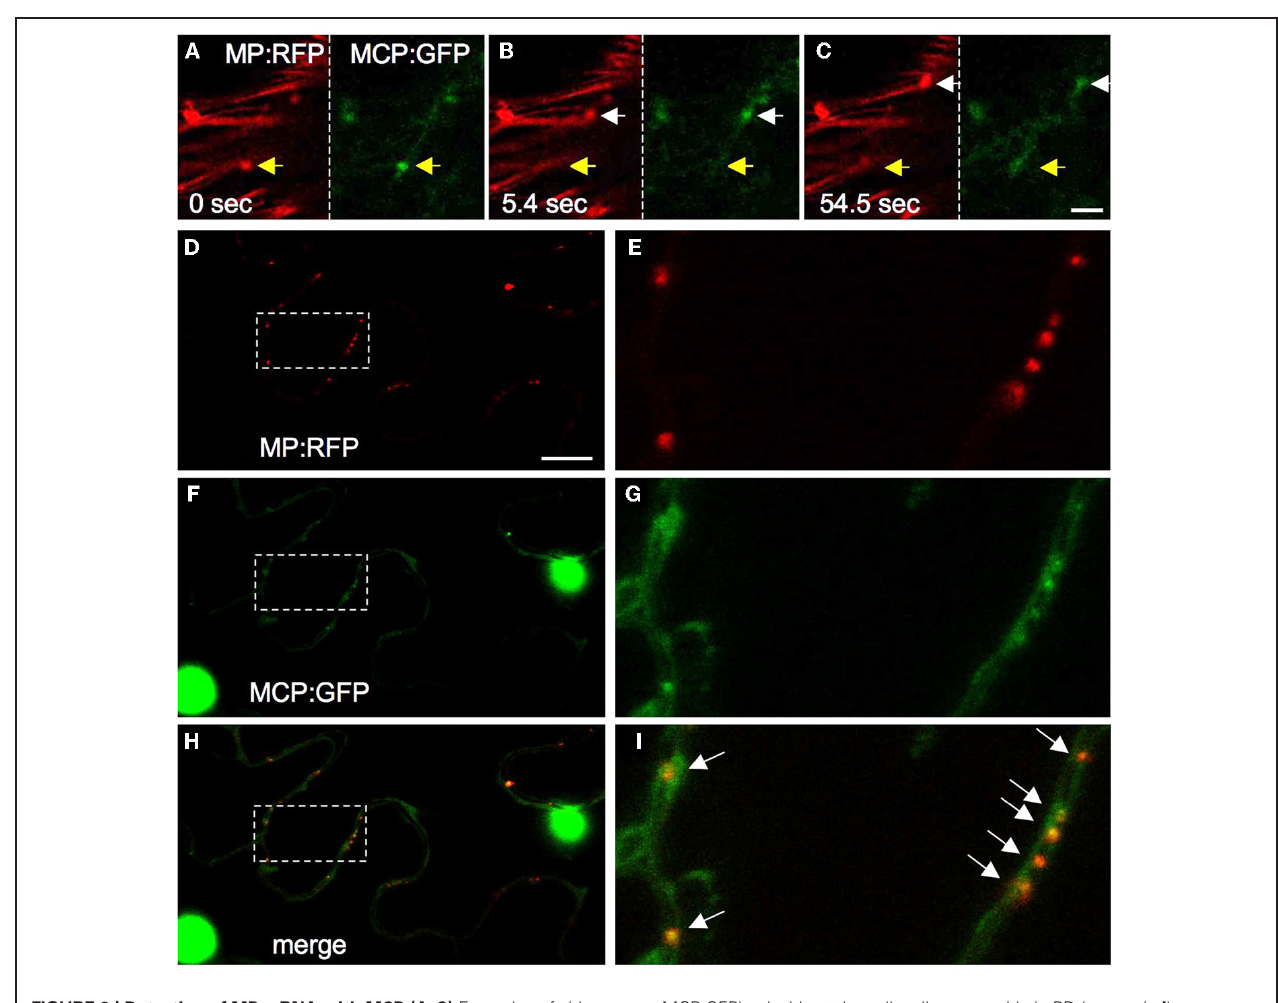
FIGURE 3 | Detection of MP mRNA with MCP. (A–C) Examples of video frames showing the coinciding movements of MP:RFP (red) and MP:RFP mRNA (green, labeled with MCP:GFP) particles. Size bar, 5 μ m. (D–I) MP:RFP ( D and E , red) and MP:RFP mRNA ( F and G , green, labeled with